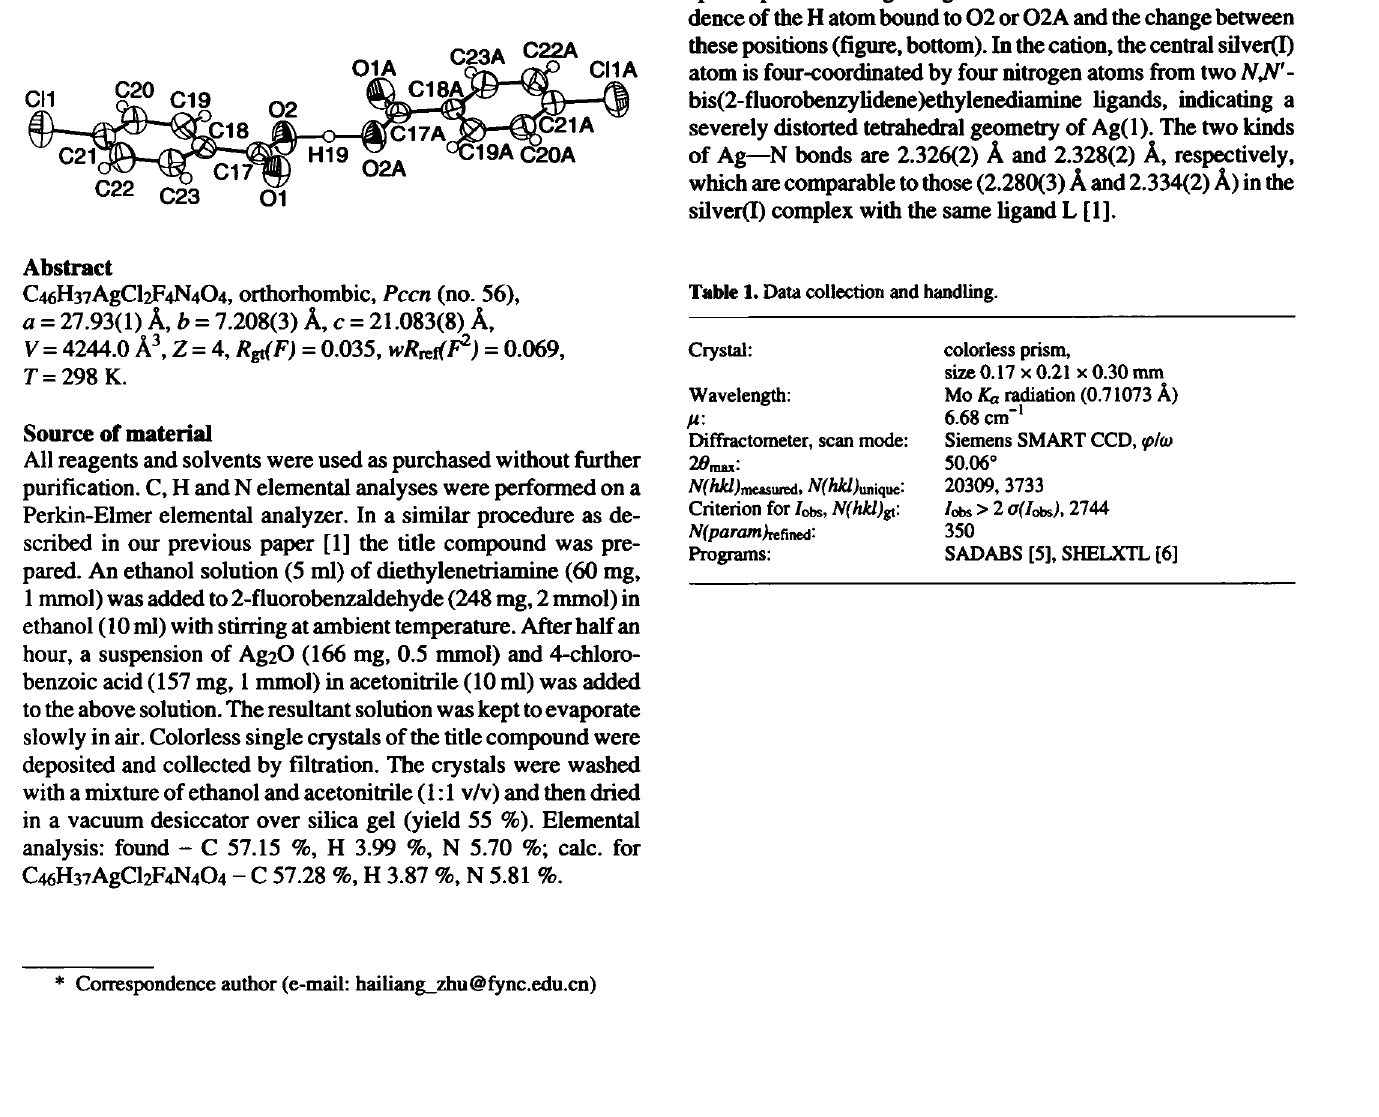
Table 1. Data collection and